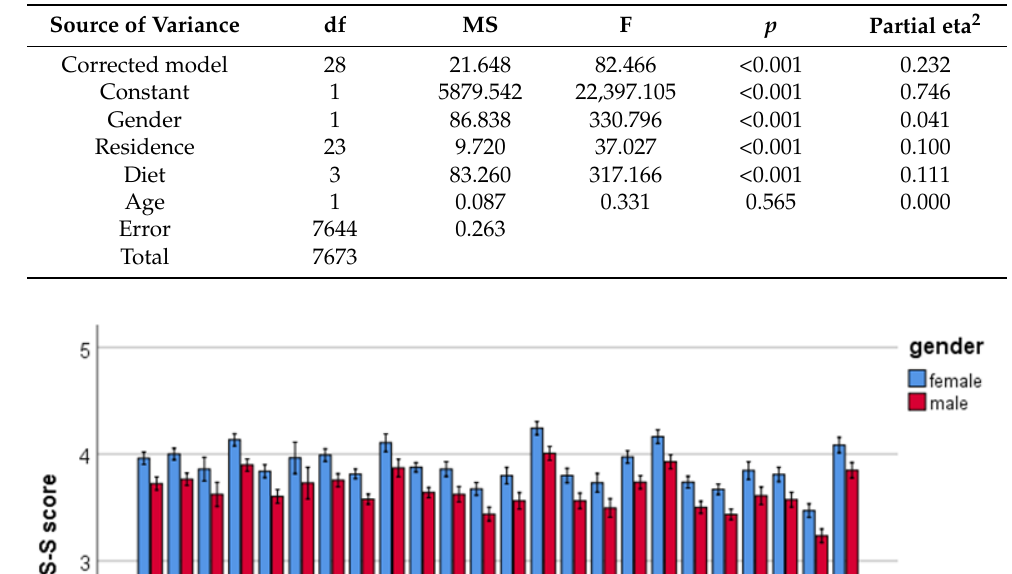
Table 2. Results of a general linear model with CRAS-S score as dependent variable, gender, residence, and diet as fixed factors, and age as covariate. MS = mean of squares, partial eta 2 = explained variance.